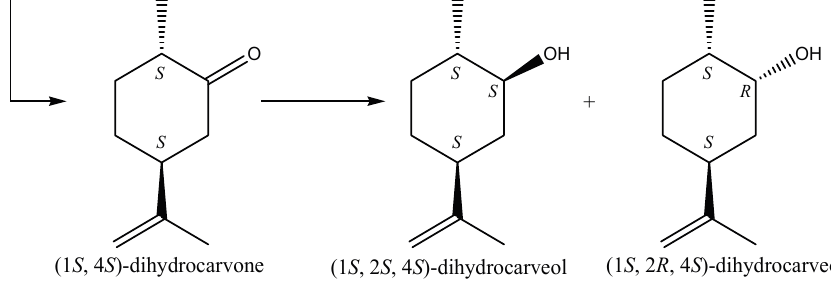
Figure 5. Bioconversion pathway of (4 S )-carvone by NCYs.